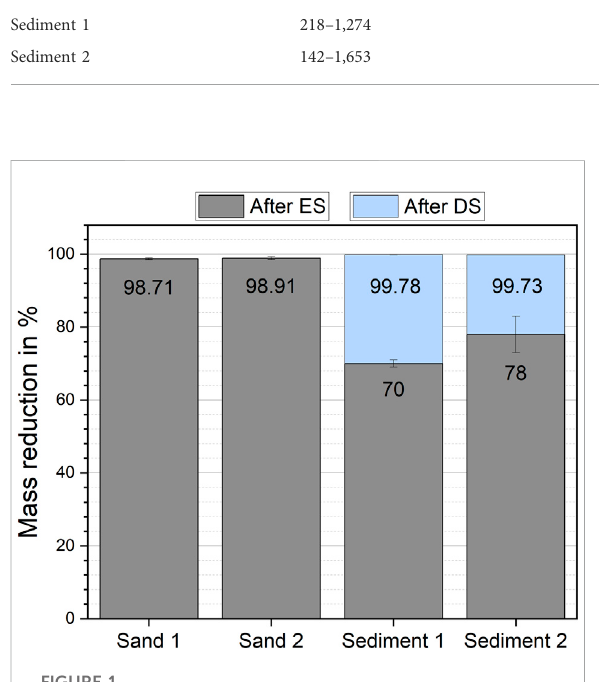
FIGURE 2 Thermogram of DSC measurements to determine